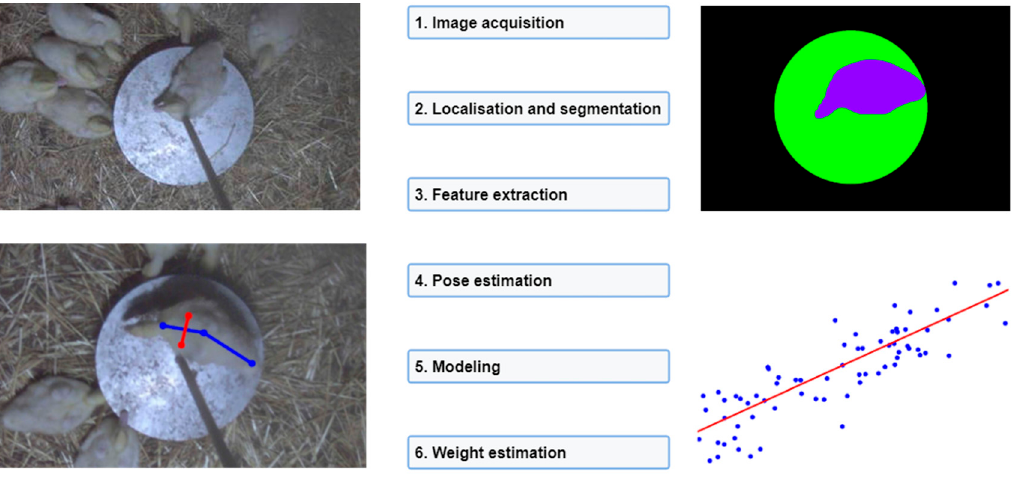
Figure 6. Image processing flowchart.